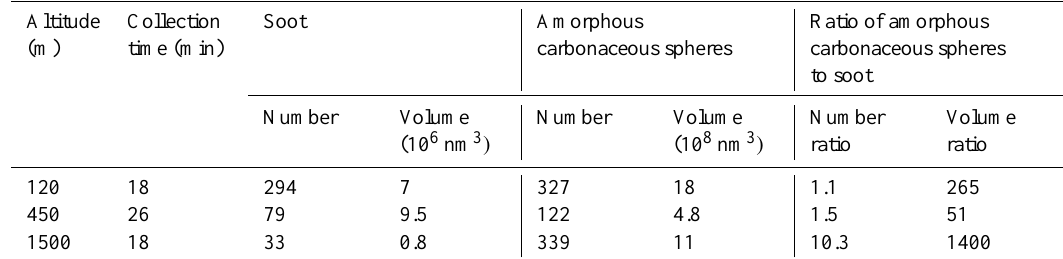
Table 2. Number, volume and their ratio in number, and volume of soot and amorphous carbonaceous spheres on 160µm 2 of the TEM grids at three altitudes.